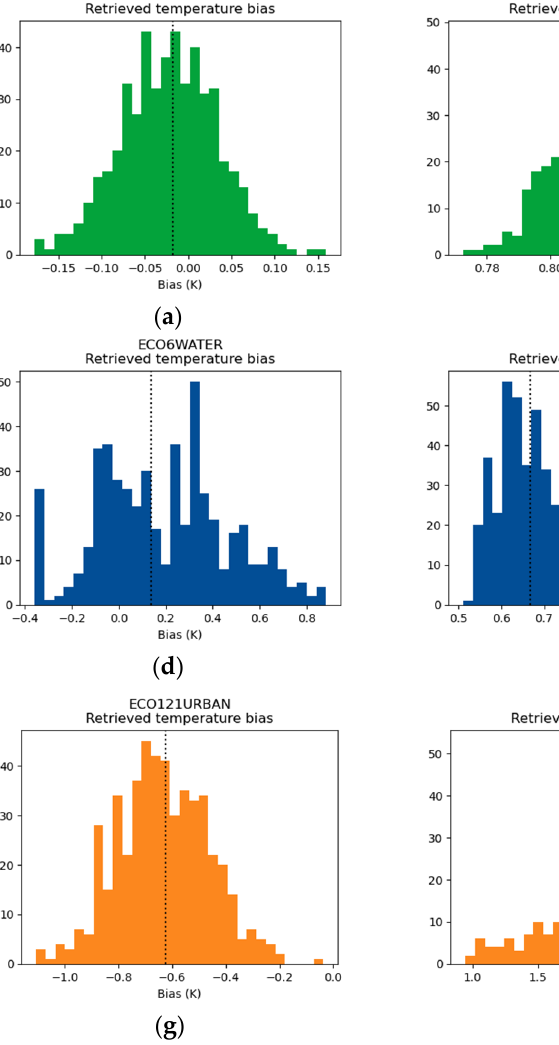
Figure 15. Bias, RMSE, and retrieved percentage obtained with DirecTES, ∆ T thresh = 3 K and ∆ ρ = 0.1 with TIR and VNIR-SWIR information, both sources of uncertainty, and 500 random divisions of the spectral library for vegetation ( a – c ), water ( d – f ), and urban materials ( g – i ). The dashed line represents the value obtained without dividing the spectral library.